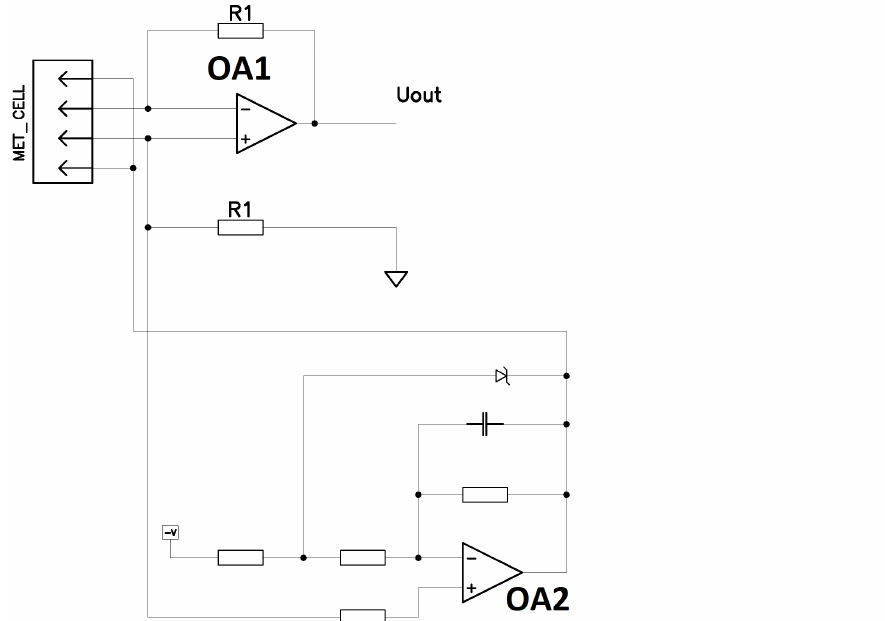
Figure 6. Scheme for electronics circuit of the MET cell. The MET cell in the figure denotes the pins connected to the electrodes of the MET cell. OA2 is operational amplifier providing potential difference between electrodes of MET cell. OA1 is operational amplifier transferring current from MET cell to